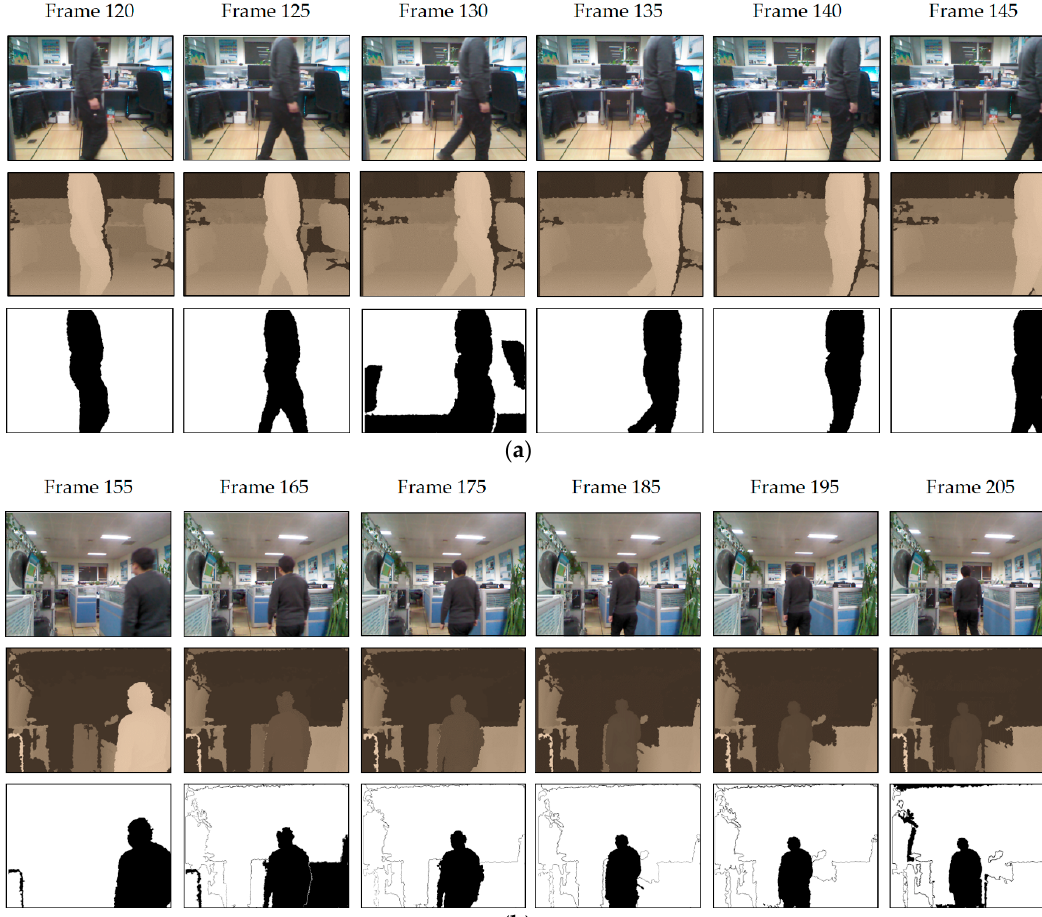
Figure 10. Selected experimental results of the proposed method using sequence images captured in an office environment. The three rows from top to bottom are RGB images, depth images, and moving object detection results. ( a ) The experimenter passed through the view with a direction parallel to the camera plane. ( b ) The experimenter walked away from the camera with a direction perpendicular to the camera plane. The moving objects detected by our method are colored in black, as shown in the third row.